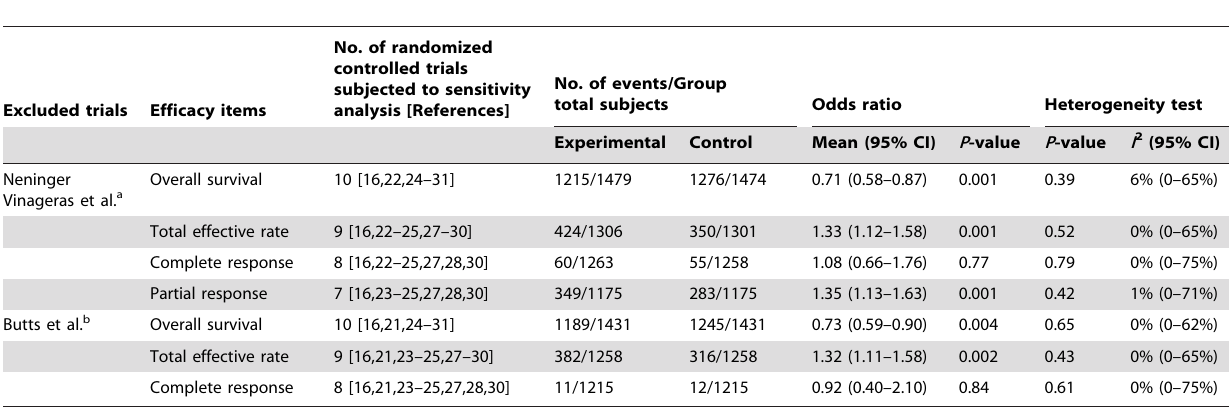
Excluded trials Efficacy